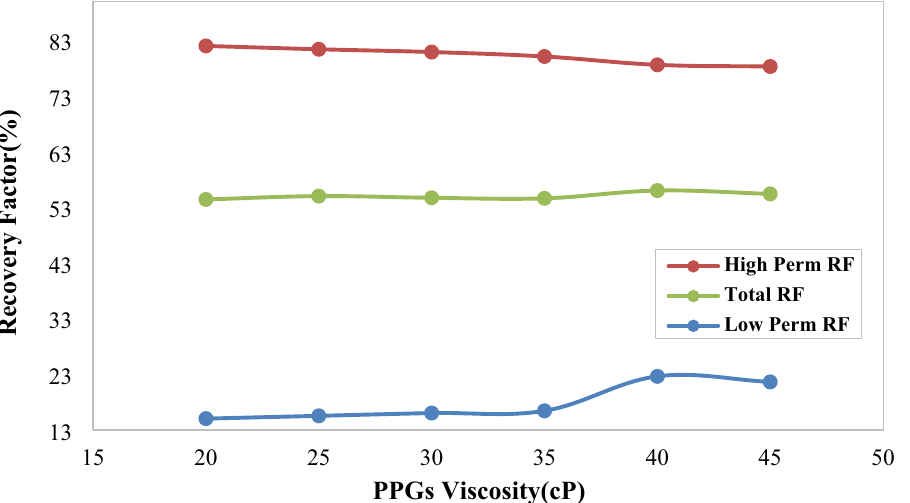
Figure 17. Effect of hydrogel viscosity on oil recovery factor in high and low permeability regions and the whole micromodel.